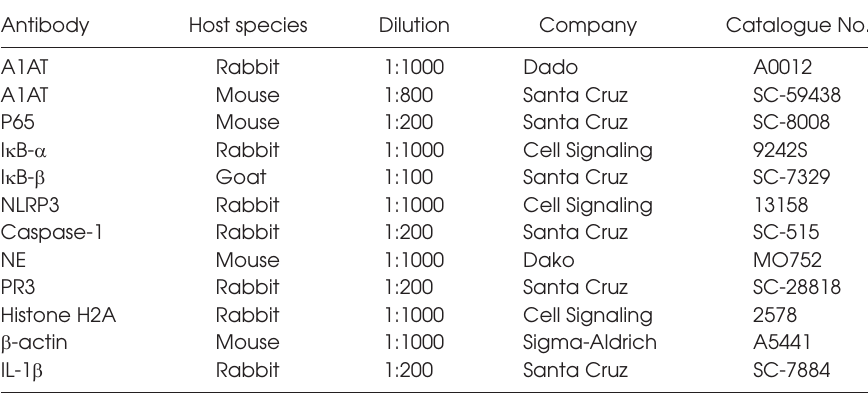
Table 2. List of the antibodies used in western blotting.